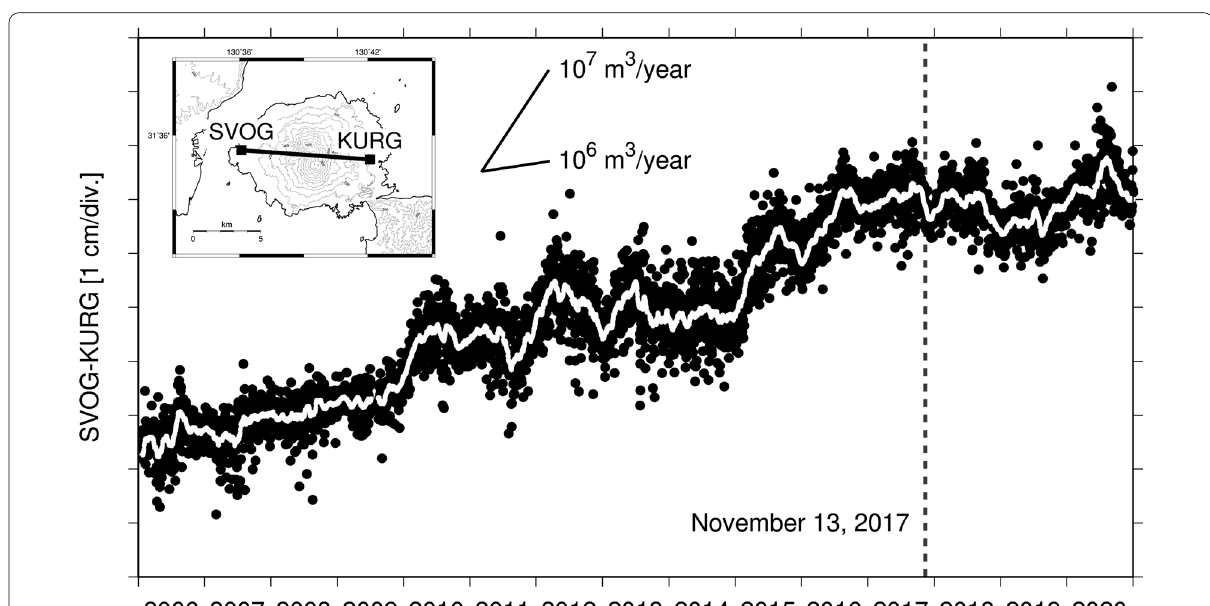
Fig. 8 Change in horizontal distance between GPS stations SVOG and KURG during the period from 2006 to 2020. The gray dashed line represents November 13, 2017. The offset due to dike intrusion on August 15, 2015 (Hotta et al. 2016b) was removed. The white line represents a 30-day rolling average trendline. The intrusion rate and corresponding slope of displacement indicated by the lines on the right side of the map is based on the